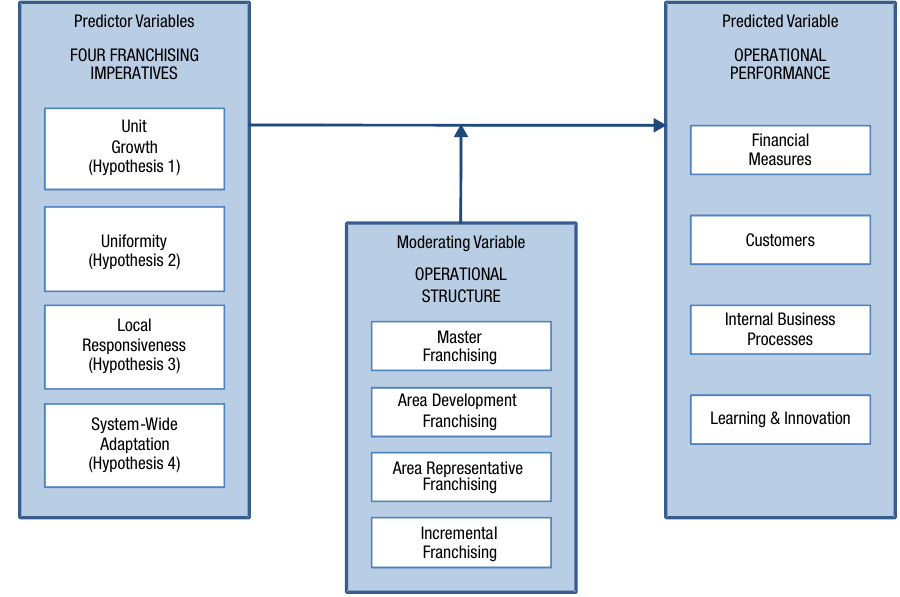
Fig. 1. Preliminary conceptual model of system operating